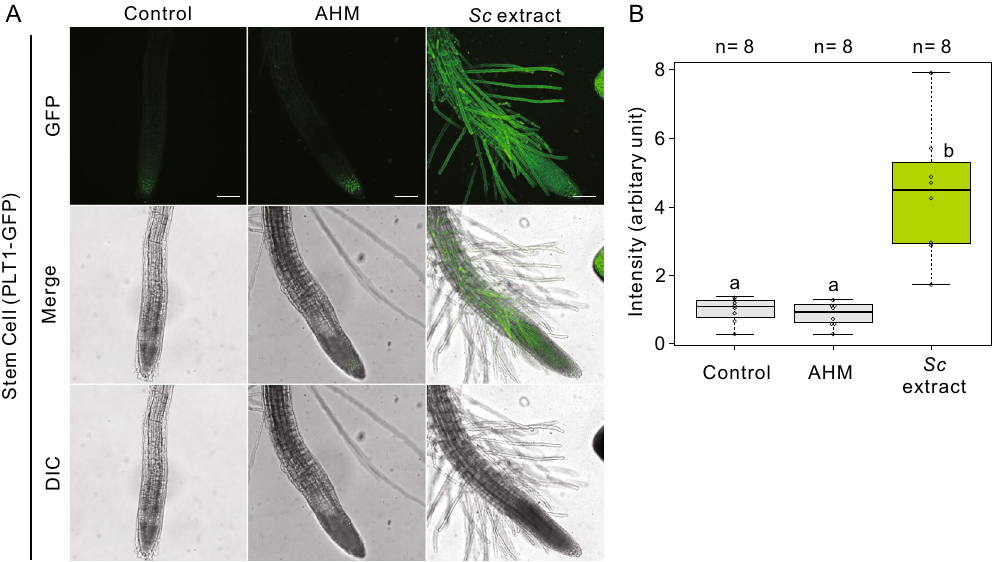
Figure 4. S. chinensis extract initialized epidermal cells of root elongation zone. ( A ) Fluorescence imaging of PLT1-GFP expressing lines without or with treatment using an artificial hormone mix (AHM) solution or S. chinensis extract. Scale bars = 100 µm. ( B ) Box-and-whisker plots showing the fluorescence intensity in ( A ) (n = 8 seedlings for each treatment, with three biological replicates). The boxes and solid lines in the boxes show the upper (75th) and lower (25th) quartiles and median values, respectively. Groups with different letters are significantly different from each other ( p < 0.05, Wilcoxon and Steel–Dwass